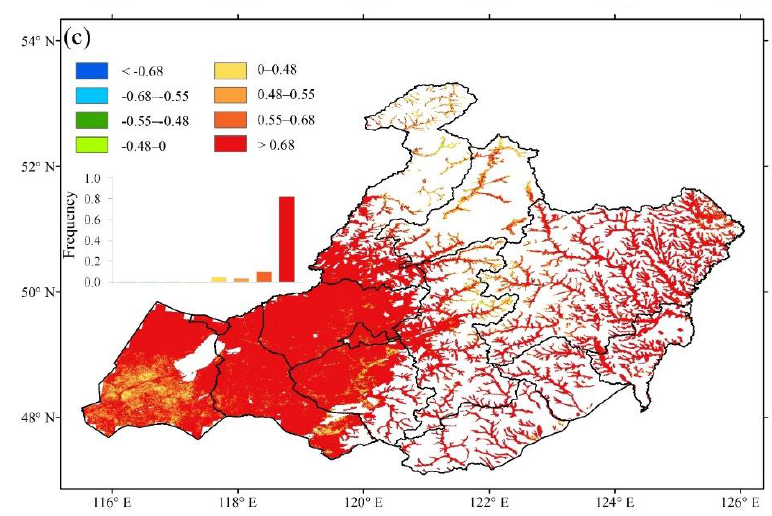
Figure 14. Spatial patterns of the interannual partial correlations between the accumulated growing degree-days requirements and chilling days ( a ), precipitation ( b ), and insolation ( c ) under the 0 °C threshold 30 days before the green-up date. Partial correlation coefficient values of ±0.68, ±0.55, and ±0.48 correspond to significance at p = 0.01, p = 0.05, and p = 0.10, respectively. Top-left insets show the frequency distributions of the correlation coefficients corresponding to the values indicated by the map legends.